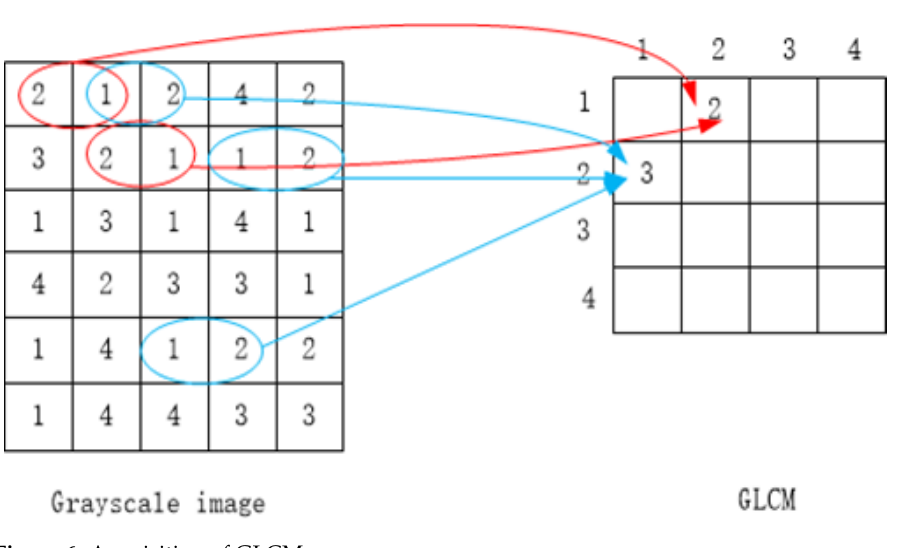
Figure 7 is the RGB histogram of the insulator. The red, blue, and green lines represent the number of pixels for each color depth in the insulator image. It can be clearly seen that most of its pixels have larger values in the red channel, so it is a red insulator. The distribution of 256 groups of color depth in R, G and B channels can be obtained by loading the RGB image of insulator with 8 bit color depth. Therefore, the amount of RGB data input to the classifier is